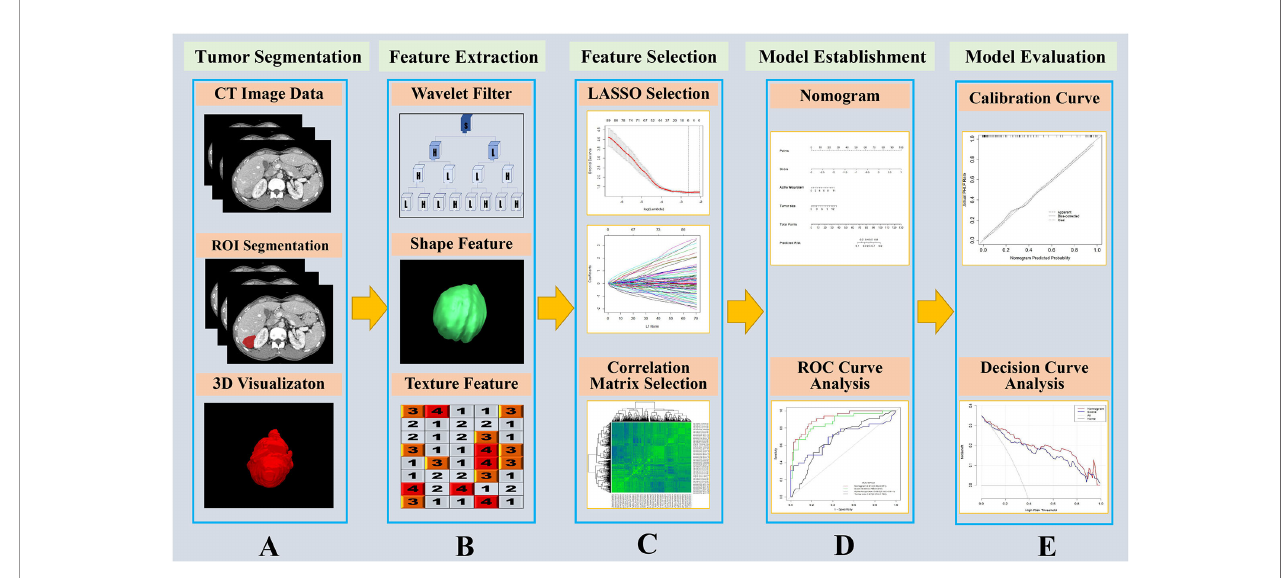
FIGURE 1 | Flow chart of the study. (A) The portal vein contrast-enhanced computed tomography (CECT) image was used as input, and the liver was segmented by homemade segmentation software (22) and manually corrected. The tumor ROI was contoured by a radiologist with more than 10 years of experience. (B) The liver parenchyma without tumor was set as the ROI image, and features containing as shape related features, texture related features and wavelet fi ltered features which were extracted by PyRadiomics software (23). (C) The extracted features were reduced via least absolute shrinkage and selection operator (LASSO) and correlation matrix selection. (D) The radiomics features and other clinicopathological variables were applied to establish a nomogram for predict microvascular invasion, and ROI curve analysis was conducted. (E) The nomogram model was evaluated with calibration curve and decision curve